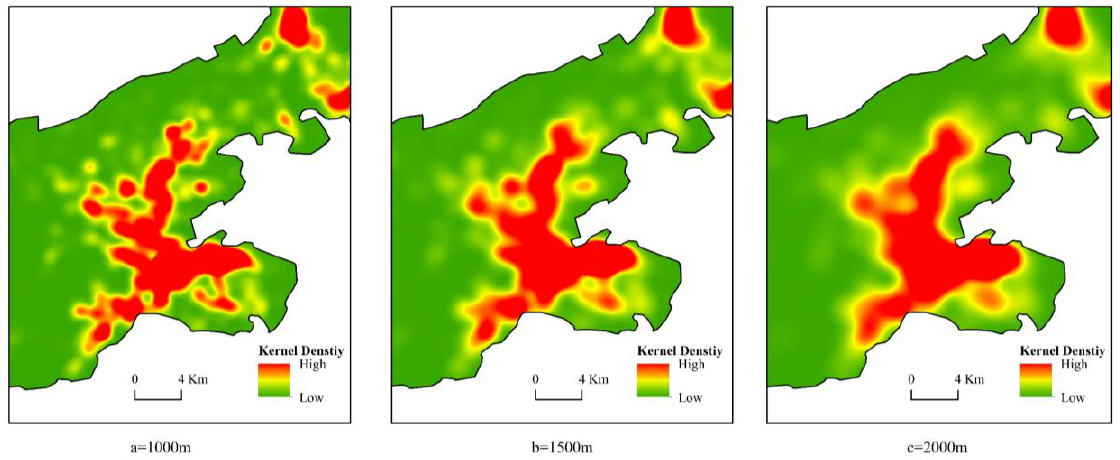
Figure 5. Kernel density estimation results for different bandwidth